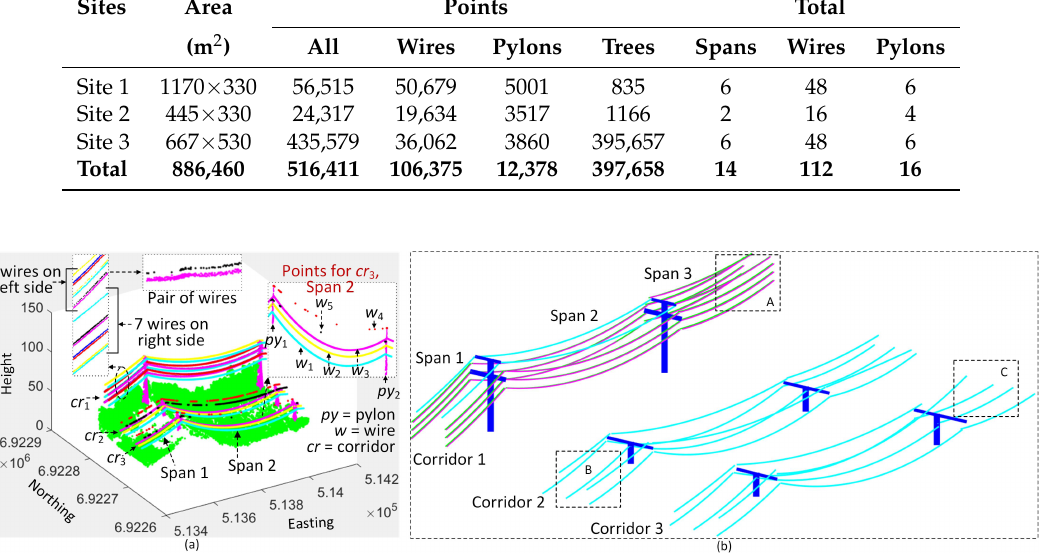
Figure 15. ( a ) Ground truth data for Site 3 (see Figure 14); and ( b ) extracted wires from an extended area of Site